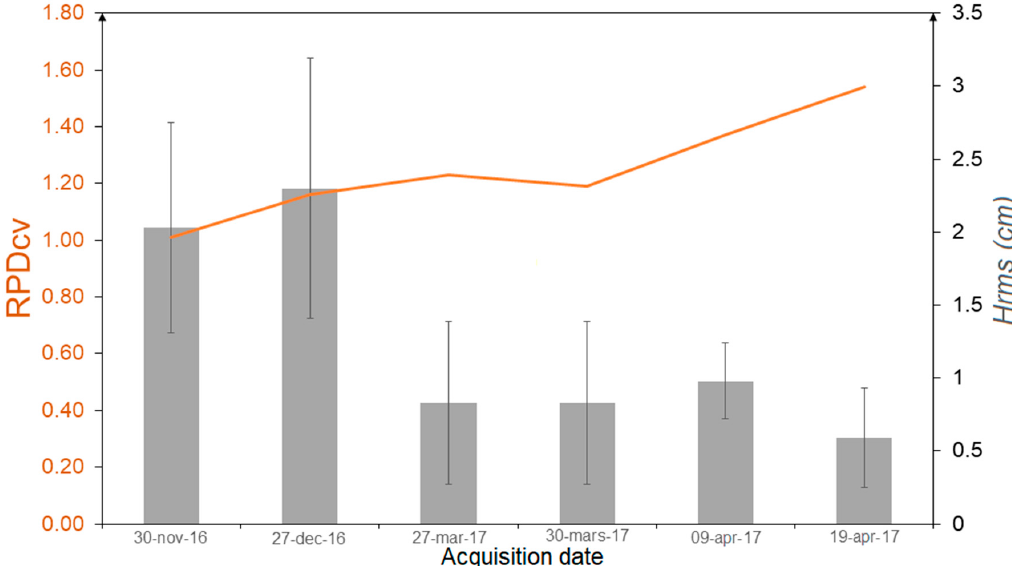
Figure 6. Evolution of prediction performance according to S2 acquisition date and S1-derived soil surface roughness for these dates (the same Hrms value was assigned to 27 and 30 March).